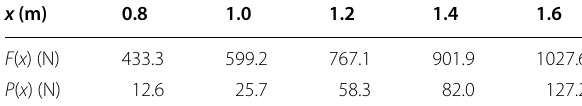
Table 5 The value of P ( x ) and F ( x ) in the case of different x